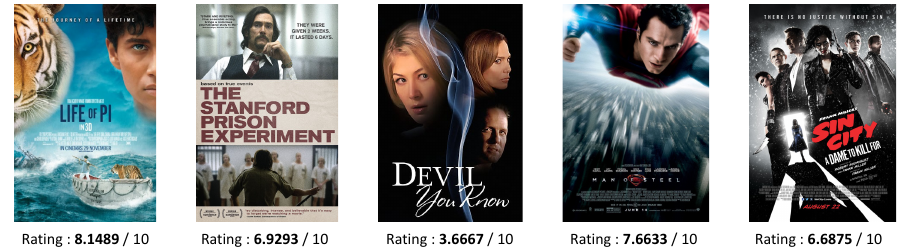
Figure 2. Examples of providing rating information ( Tweetings